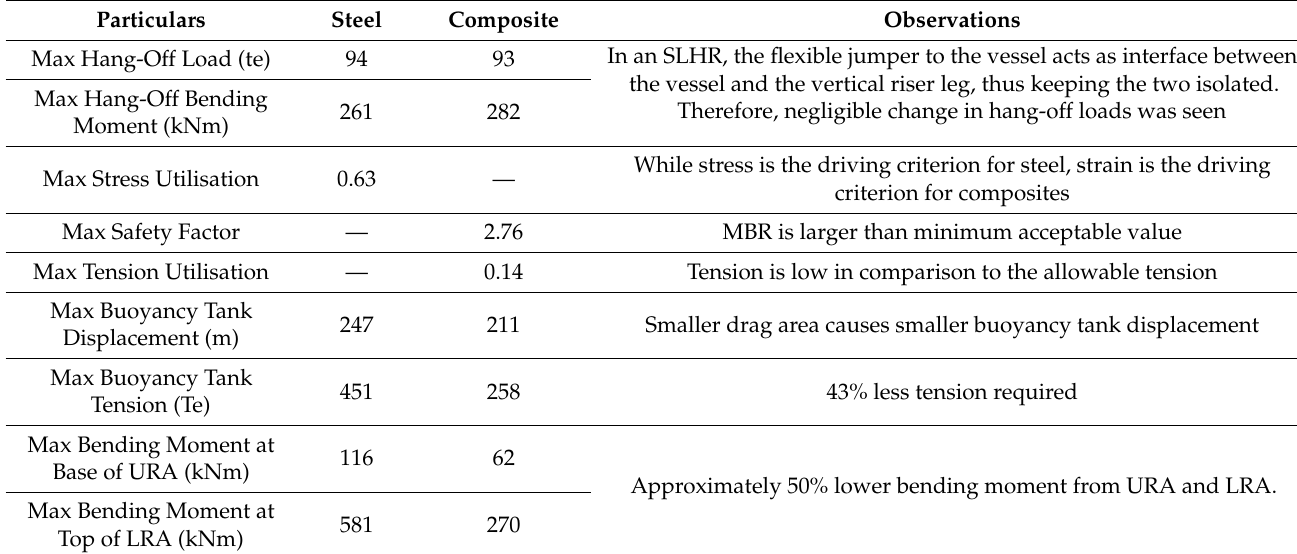
Table 10. Comparison of the main design aspects of composite riser and steel riser. (Source: [199]).